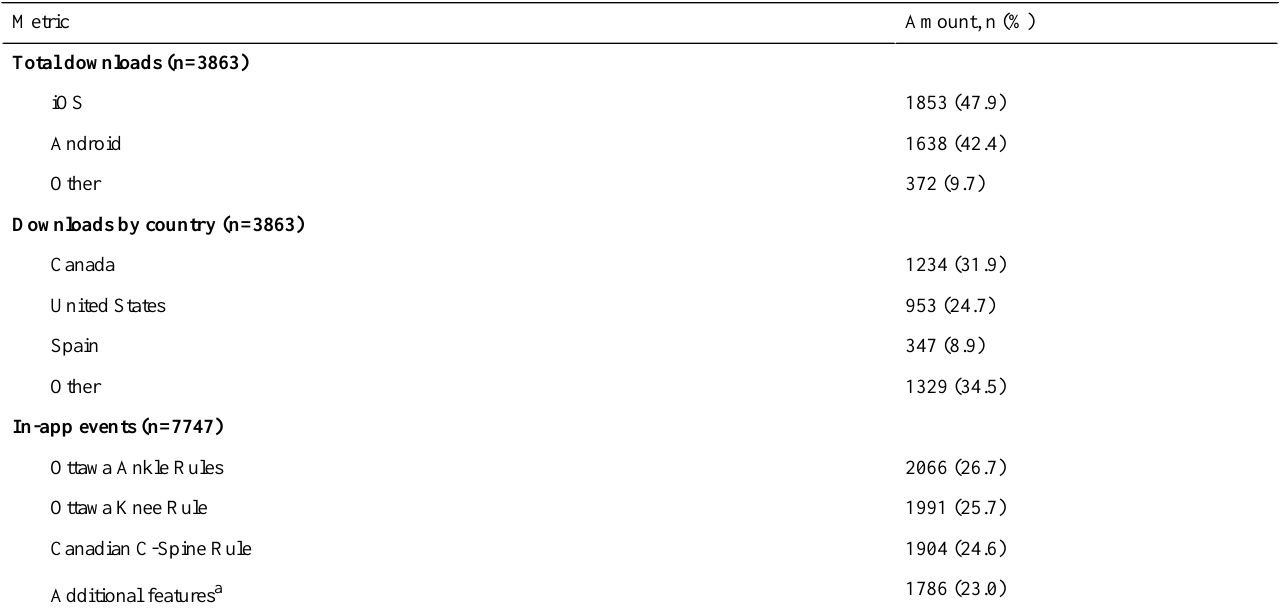
Table 3. App activity from April 21, 2016, to June 1,